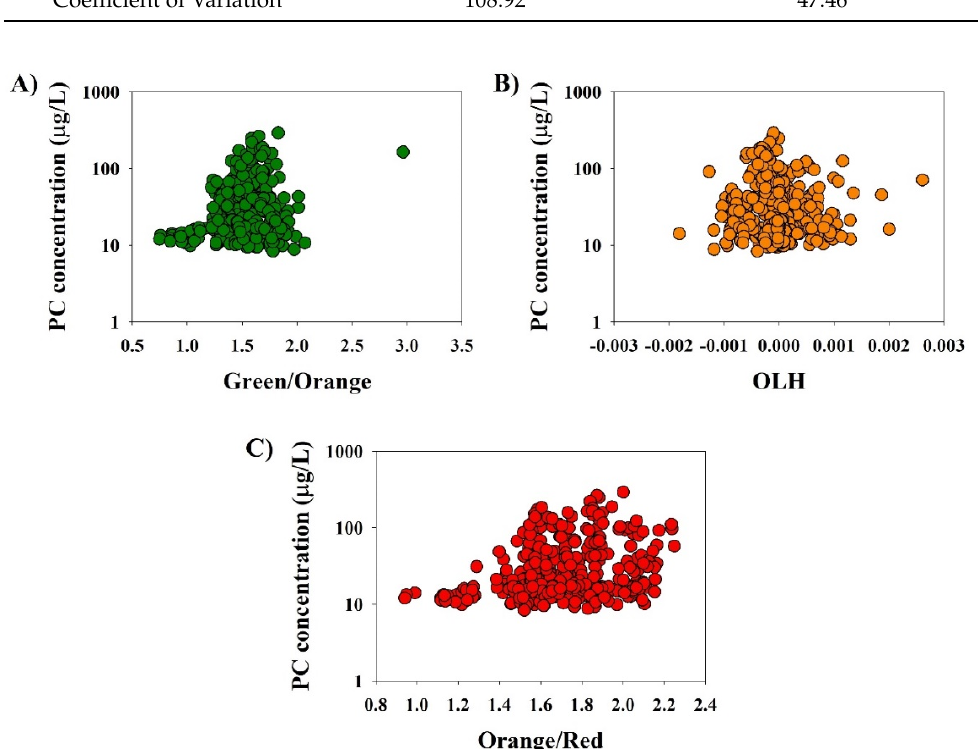
Figure 3. PC concentration (in log scale) and remote sensing models relationship using the entire dataset ( n = 332). ( A ) for the green:orange ratio; ( B ) for the OLH; and ( C ) for the orange:red ratio. Table 2. Best fit for each remote sensing model for each To improve these relationships, we used only the samples with a PC concentration higher than 50 μg/L—which was described by Ruiz–Verdu et al. [22] as the optimal con- centration for PC retrieval (Figure 4). The resultant R 2 values were improved for the green:orange ratio (R 2 = 0.16) and the OLH (R 2 = 0.24) with a geometric fit, but decreased for the orange:red ratio with a logarithmic fit (R 2 = <0.01). Overall, the use of PC concen- tration higher than 50 μg/L did not significantly improve the retrieval of PC. Nevertheless, it was observed that green/orange ratio performed slightly better than the other two mod- els.